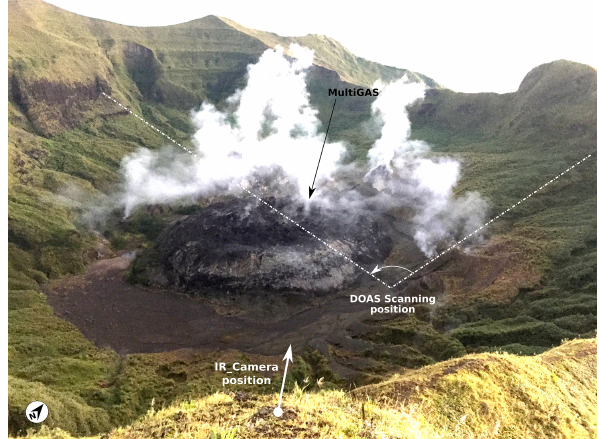
Figure 2. Awu lava dome in the crater. Degassing occurs from the lower crater wall, and the northern part of the crater is the main de- gassing zone. The positions of DOAS scanning, MultiGAS (MG), and infrared camera are highlighted. The arrow of the IR_cam de- notes the direction of the thermal